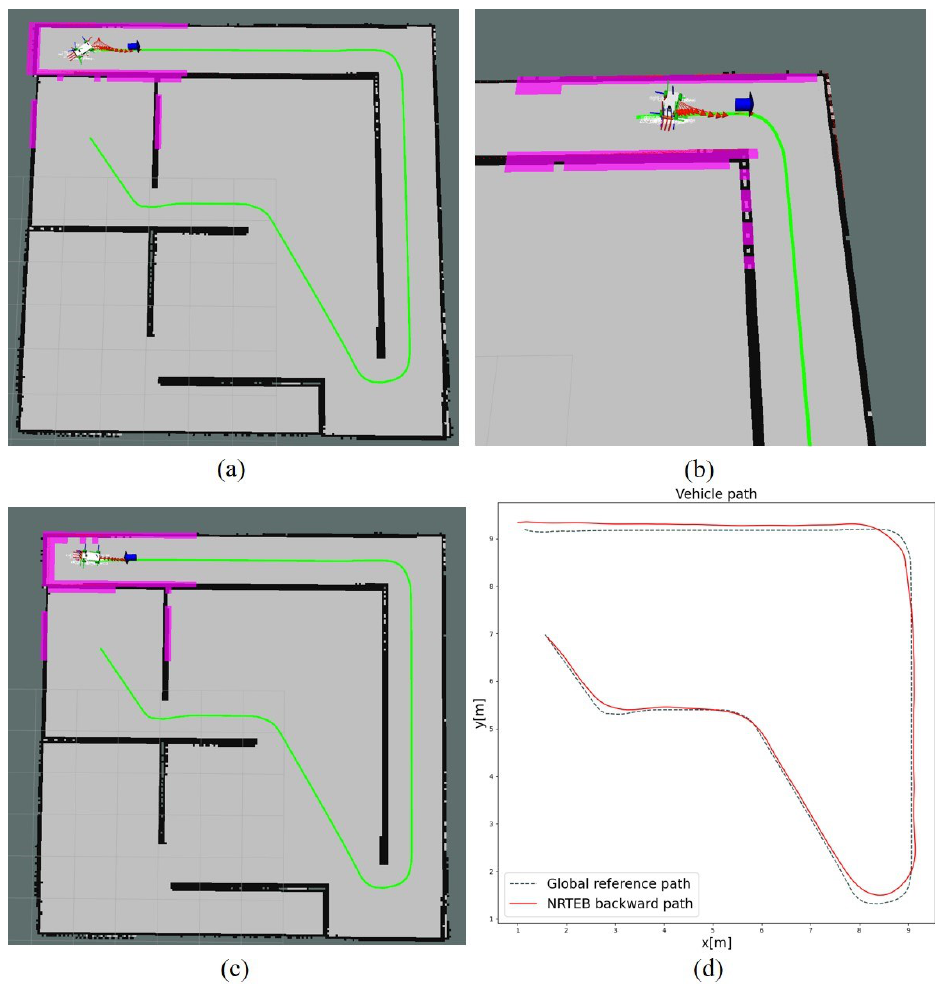
Figure 13. ( a ) Reversing trajectory generated by TEB. The red arrow represents the pose of the trajectory point and the blue arrow indicates the local target. ( b ) TEB’s reversing planning results in a narrow corner. ( c ) The straight reversing trajectory generated by NRTEB. ( d ) The comparison of the global path generated by A* algorithm and the reversing path with the